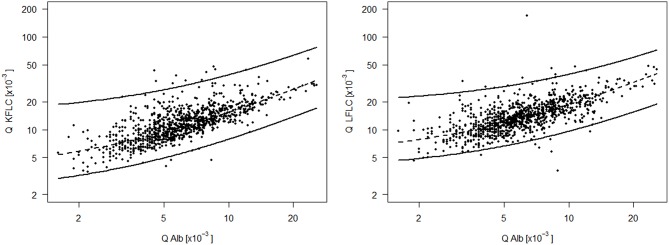
CSF-serum ratio of kappa (Q KFLC) and lambda (Q LFLC) free light chain is plotted against the respective CSF-serum ratio of albumin (Q Alb) on the log scale. The upper line is the 99% quantile estimated by linear quantile regression and indicates the upper reference value of Q KFLC and Q LFLC dependent on Q Alb and based on a control group of 989 non-inflammatory neurologic diseases and a range of Q Alb from 1.6*10−3 to 25.7*10−3. Formula for the Q Alb dependent upper reference value (upper line): Q KFLC = 9.50 + 2.08*Q Alb; Q LFLC = 16.37 + 1.36*Q Alb. The lower line is the 1% quantile line and the dashed line in the middle is the 50% quantile (median) line.